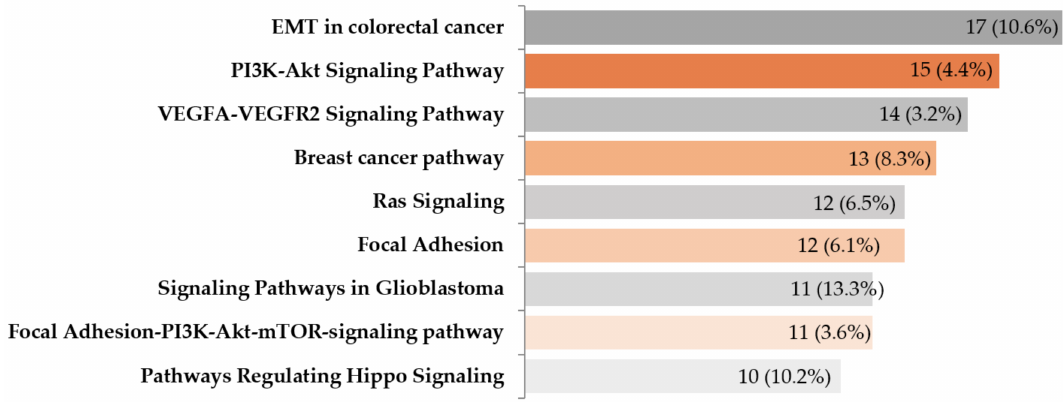
Figure 7. A list of metabolic pathways with 10 and more genes deregulated in M3 tumors selected using GeneSpring software. The numbers in individual columns show the number of genes from our dataset, while the percent represents the proportion of identified genes in a given metabolic